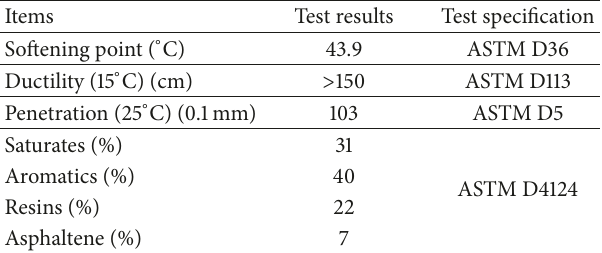
Table 1: Physical properties and chemical components of the base asphalt.